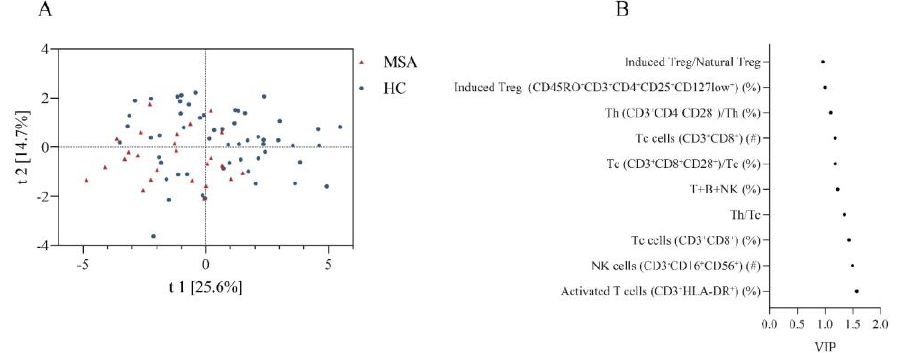
Figure 2. The discrepancy of peripheral immune traits between MSA and HC. ( A ) Obvious separation in the PLS-DA model indicates a different structure of peripheral immune traits between MSA and HC. ( B ) Top 10 peripheral immune indices with highest VIP value between MSA and HC. Abbreviations: MSA: multiple system atrophy; HC: healthy controls; PLS-DA: partial least squares discriminate analysis; VIP: variable importance in the projection.